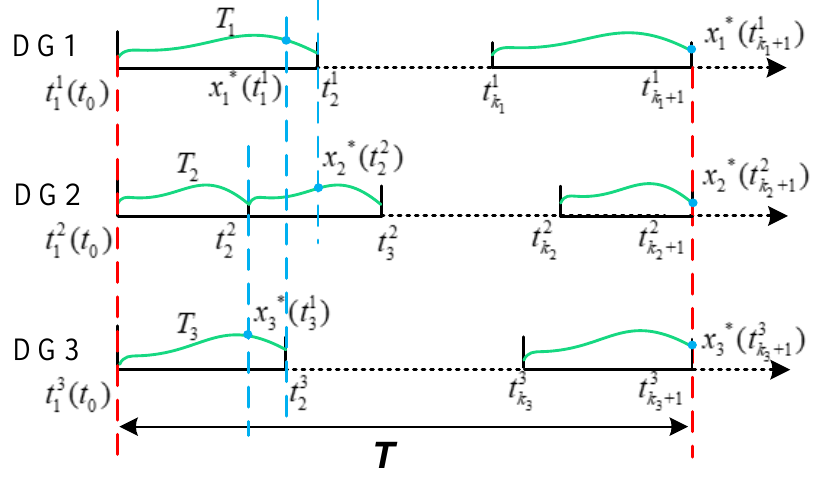
Figure 4. Periodicity in the sampling time offset during information interaction. As stated previously, the primary and secondary control layers are operated with different control periods. The primary control instants of individual DGs within the cycle period T are represented by t 1 , t 2 , . . . , t n , where n = T / T s , and the update process of k k k the measured powers and voltages at the primary control instant t l can then be expressed k based on (22) and